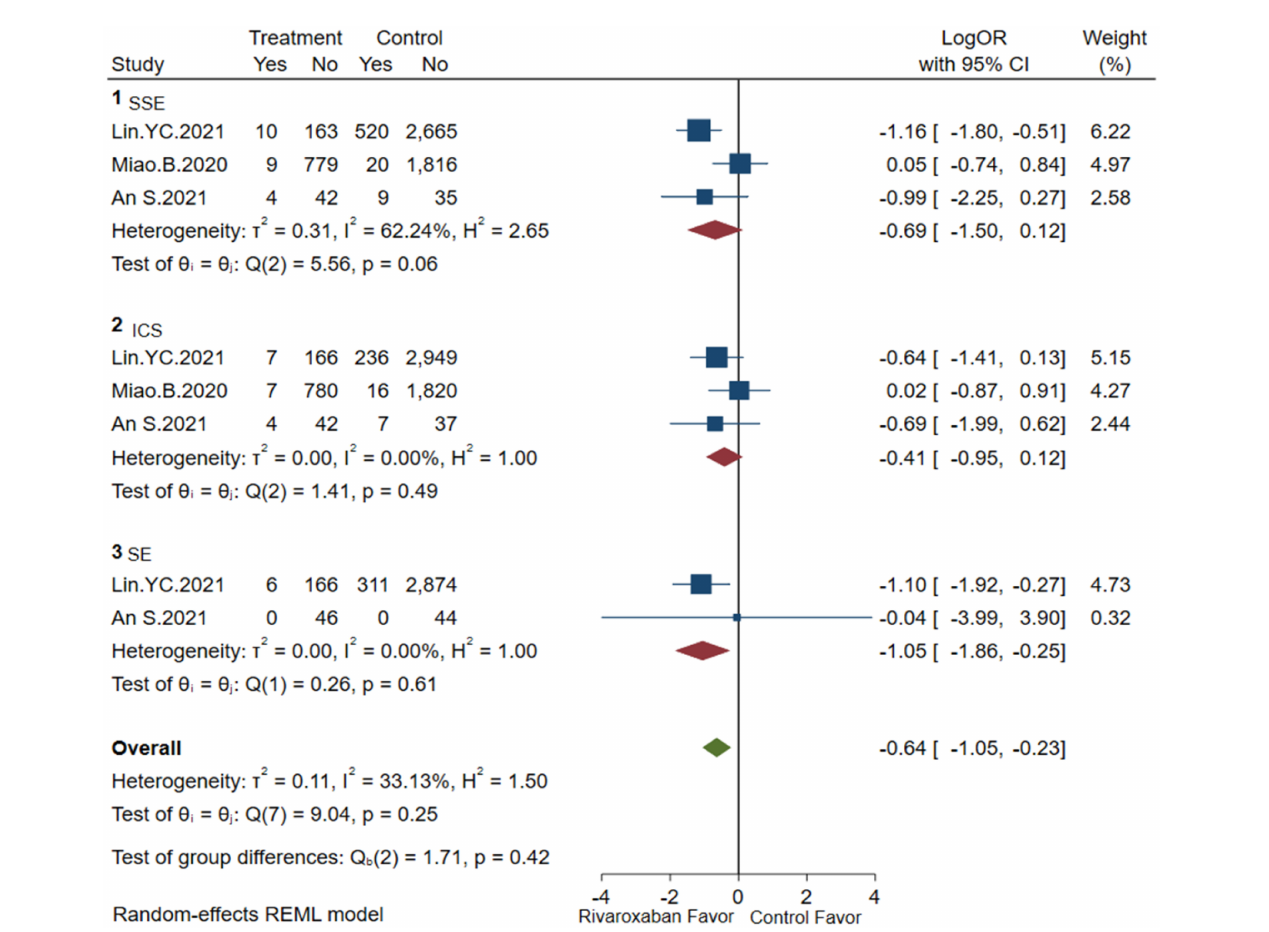
FIGURE2 Embolism of mix-dose rivaroxaban (SSE, composite of stroke and systemic embolism; ICS, ischemic stroke; SE, systemic